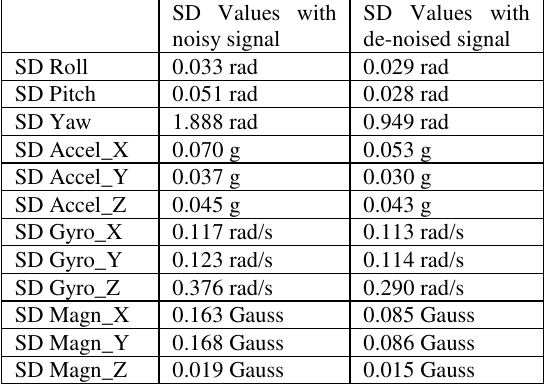
Table 3. Standard Deviation values of inertial sensor noised and